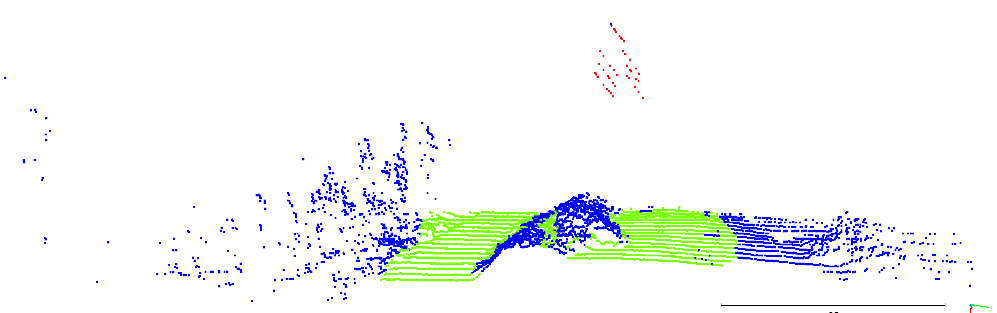
Figure 14. Segmented point cloud from one scan, colored by point type. Green corresponds to planar , red to potential lines and blue to undefined .